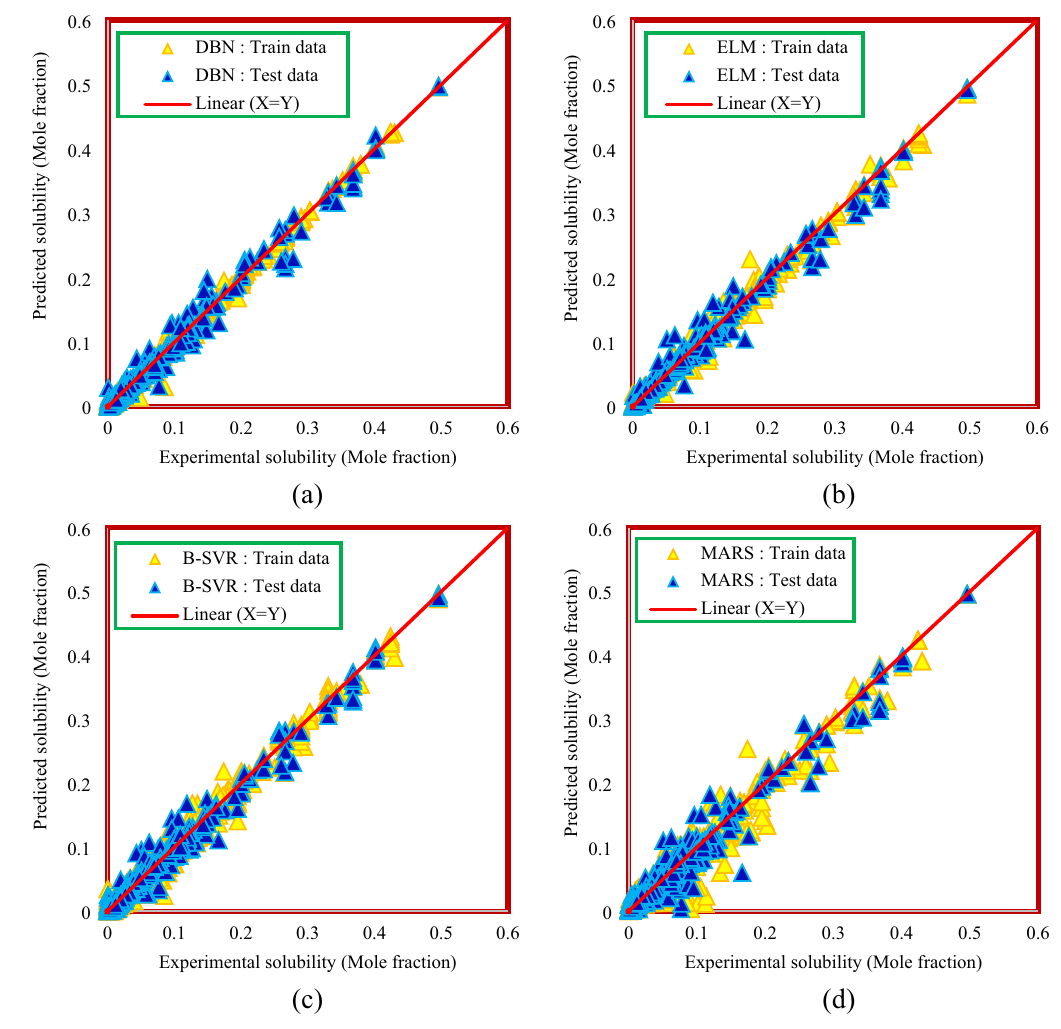
Figure 8. Cross plot diagram of the results of Model (I): ( a ) DBN model, ( b ) ELM model, ( c ) B-SVR model, ( d ) MARS